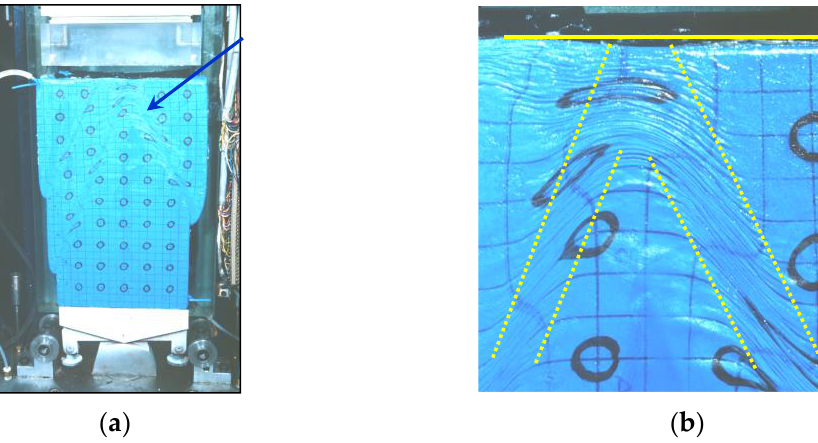
Figure 12. Observations made during the biaxial test: ( a ) general view of the biaxial apparatus with a sample after the test; ( b ) multiple shear bands of nonzero thickness, wide deformations, and «reflection» on the upper surface (source: phot . of Jacques Desrues, 2003; (after [109], available via 2021 Desrues’ permission).